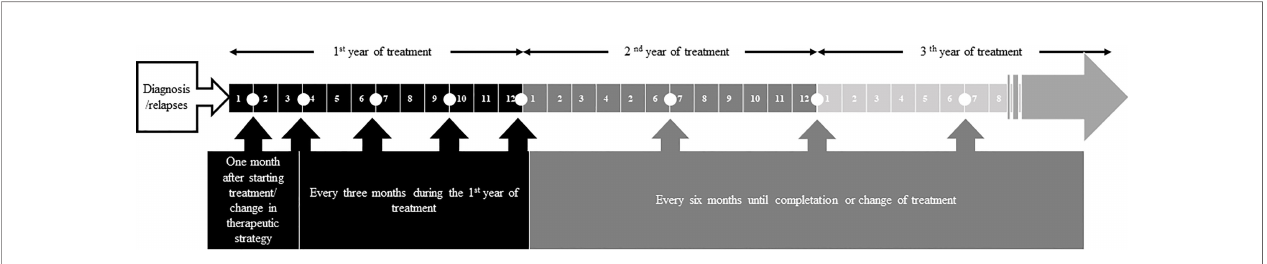
FIGURE 2 | Frequency of PROs collection in clinical